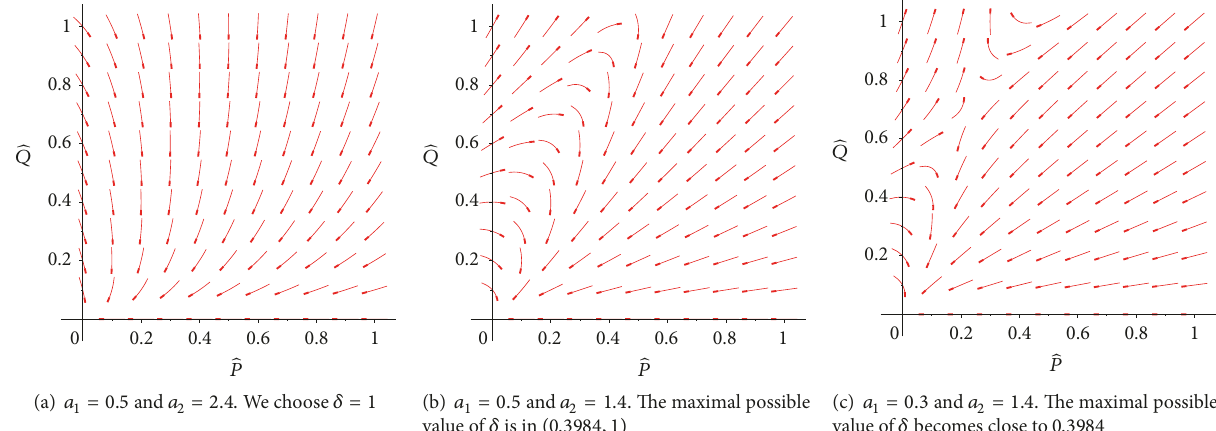
Figure 1: The phase portrait of system (80) when 𝜖 1 = 0.003 and 𝑟 = 1.875